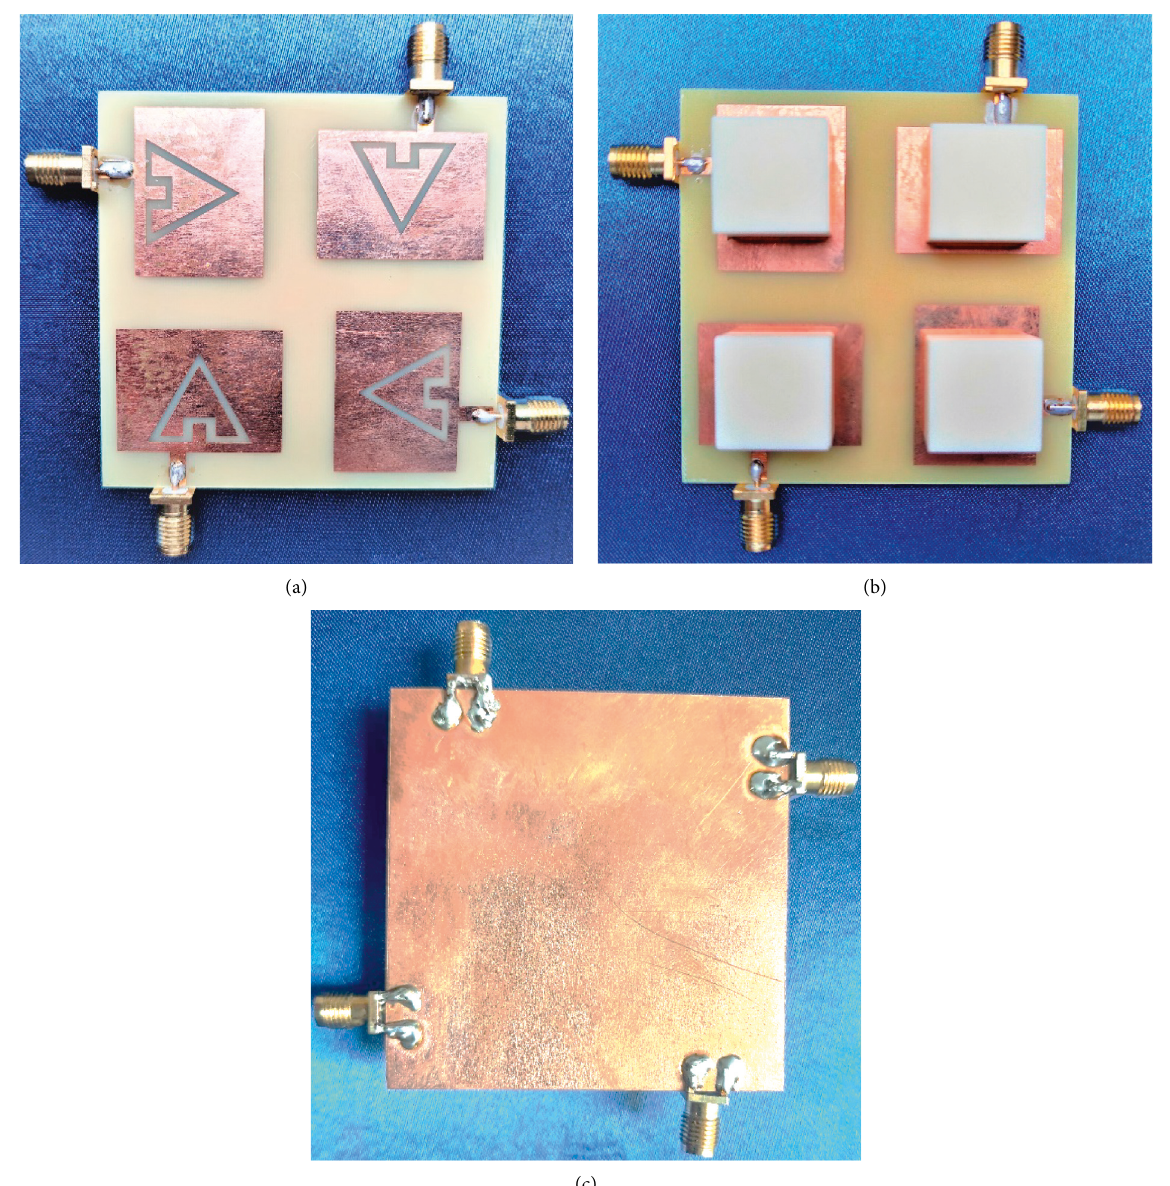
Figure 6: Proposed MIMO antenna: (a) top view without DR, (b) top view with DR, and (c) bottom